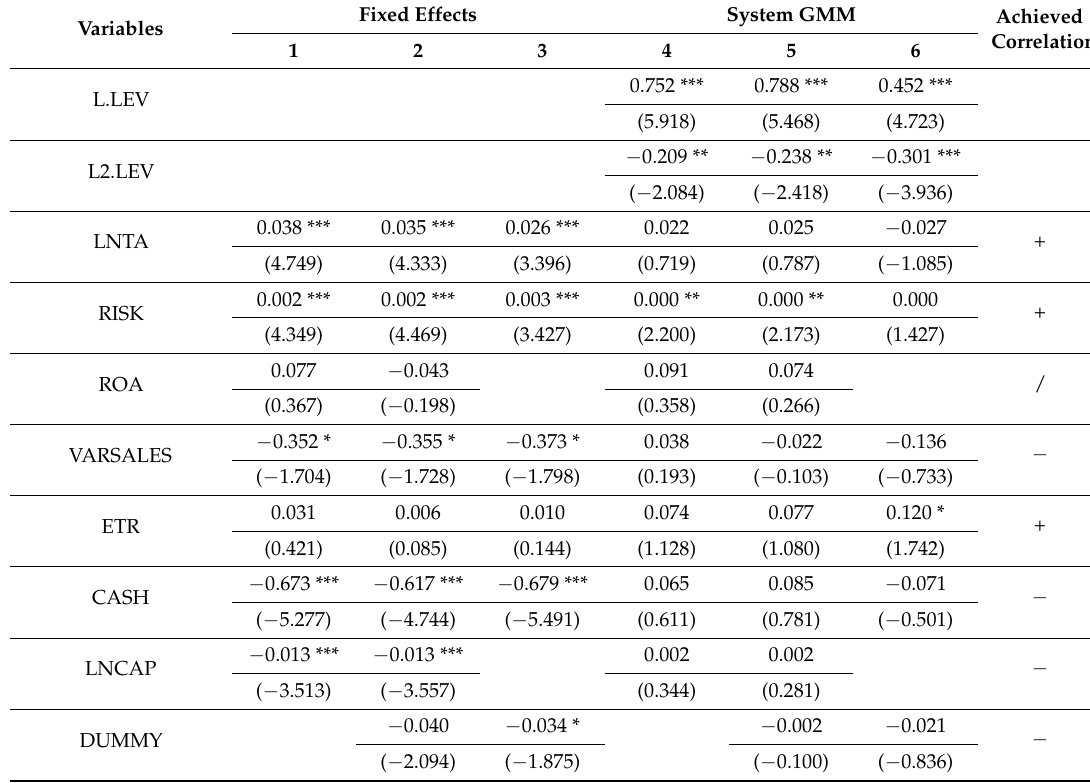
Table 8. Econometric results—dependent variable